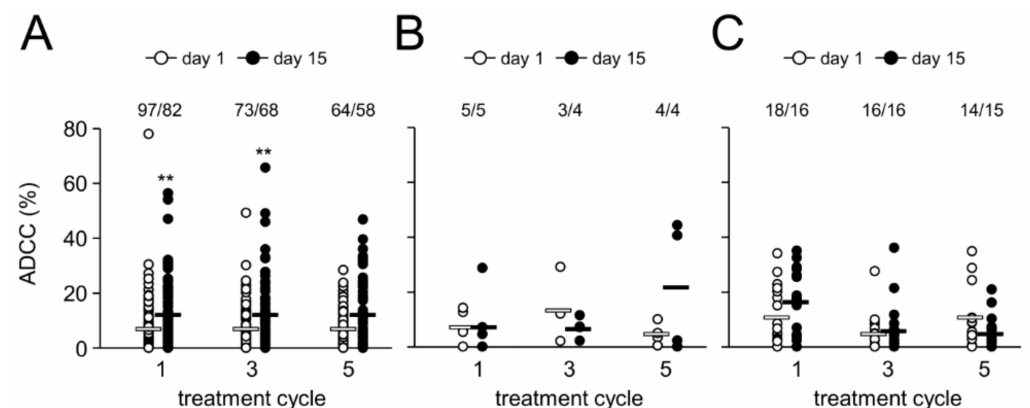
Figure 4. Ch14.18/CHO-mediated ADCC and impact of HACA response. Induction of GD 2 -specific ch14.18/CHO-mediated ADCC in HACA-negative ( A ) and HACA-positive pts (non-neutralizing ( B ) and neutralizing pts ( C )) treated with the LTI regimen was analyzed in cycles 1, 3 and 5 on d15 (closed circles) and compared to the baseline cytotoxicity of the respective cycle (d1; open circles). ADCC was evaluated against the GD 2 -positive NB cells LAN-1 as described in “Materials and Methods”. The circles represent pts evaluable for the analysis (number of pts are shown above the respective groups). Experiments were performed in six replicates. White (non-neutralizing) and black solid horizontal bars (neutralizing) indicate mean values of the respective group. t -test or Mann-Whitney Rank Sum test. ** p < 0.01 vs. d1 of the respective